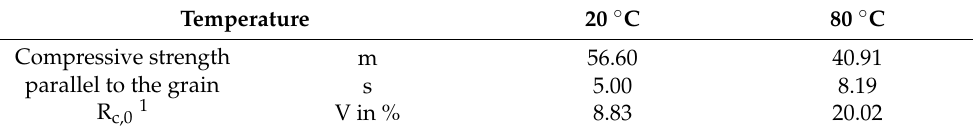
Table 5. Results of wood compressive strength tests parallel to the grain at 20 ◦ C and 80 ◦